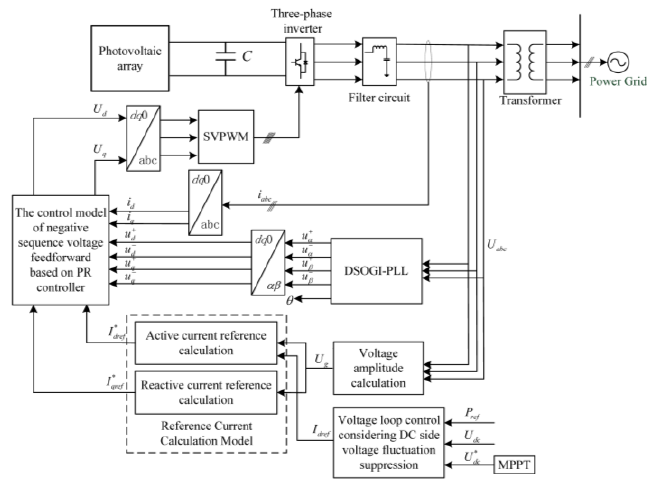
Figure 3. Model of the inverter